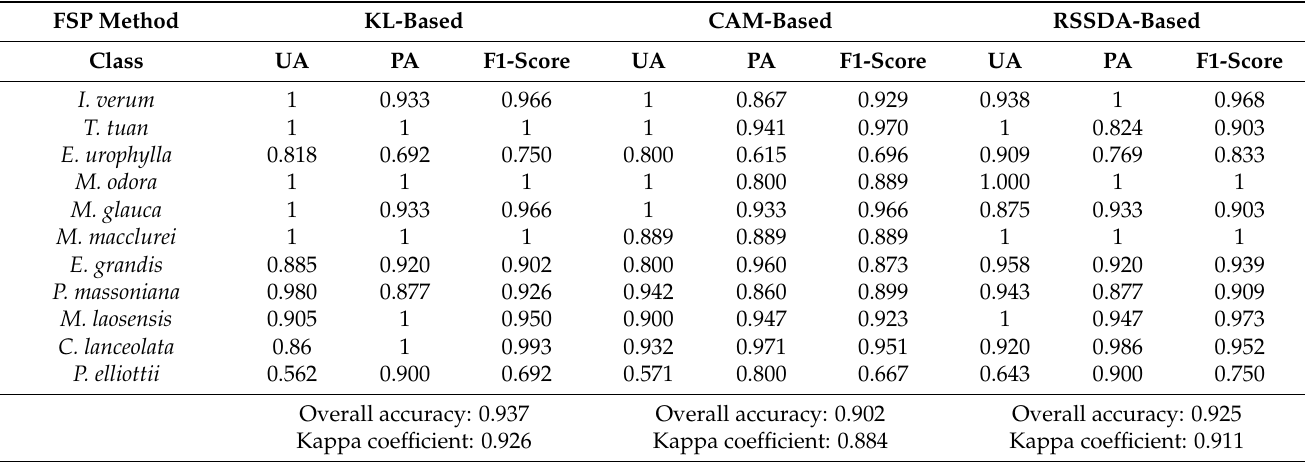
Table 3. Classification accuracies of the FSP method based on the Kullback–Leibler divergence (KL), curve angle mapper (CAM), and root sum squared differential area (RSSDA) curve matching classifiers.